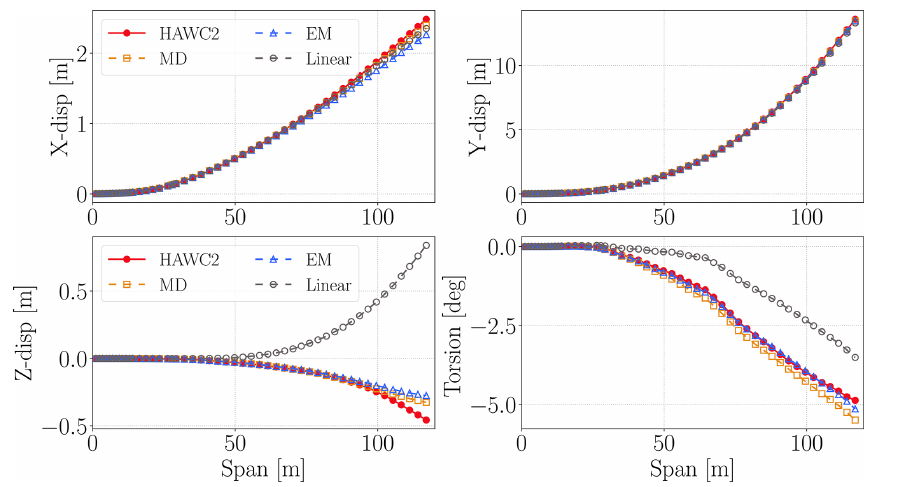
Figure 15. Spanwise deflection results at the time when the minimum torsion occurs (70.66s).